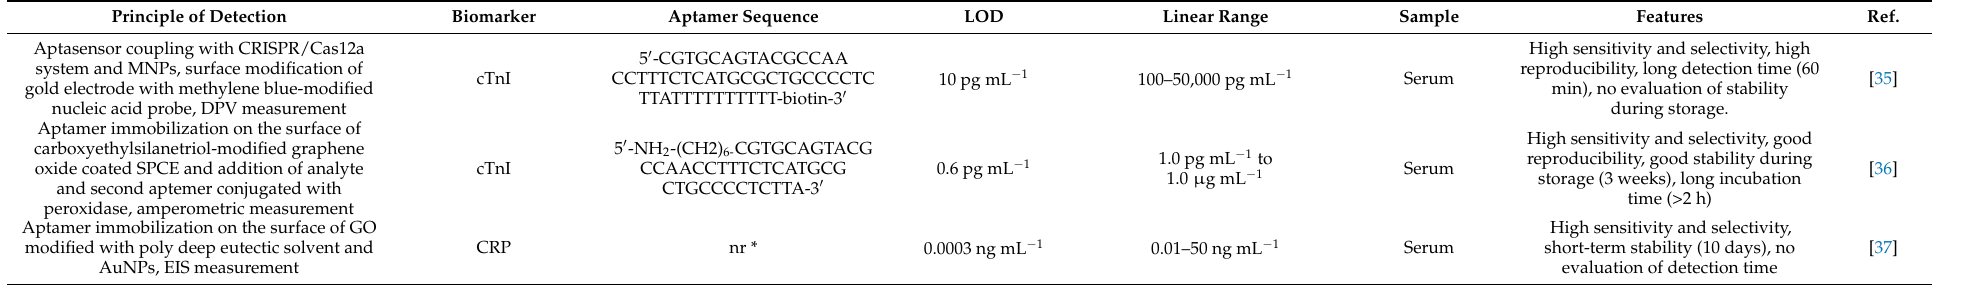
Table 2. Recent advances in electrochemical aptasensors for the detection of cardiac